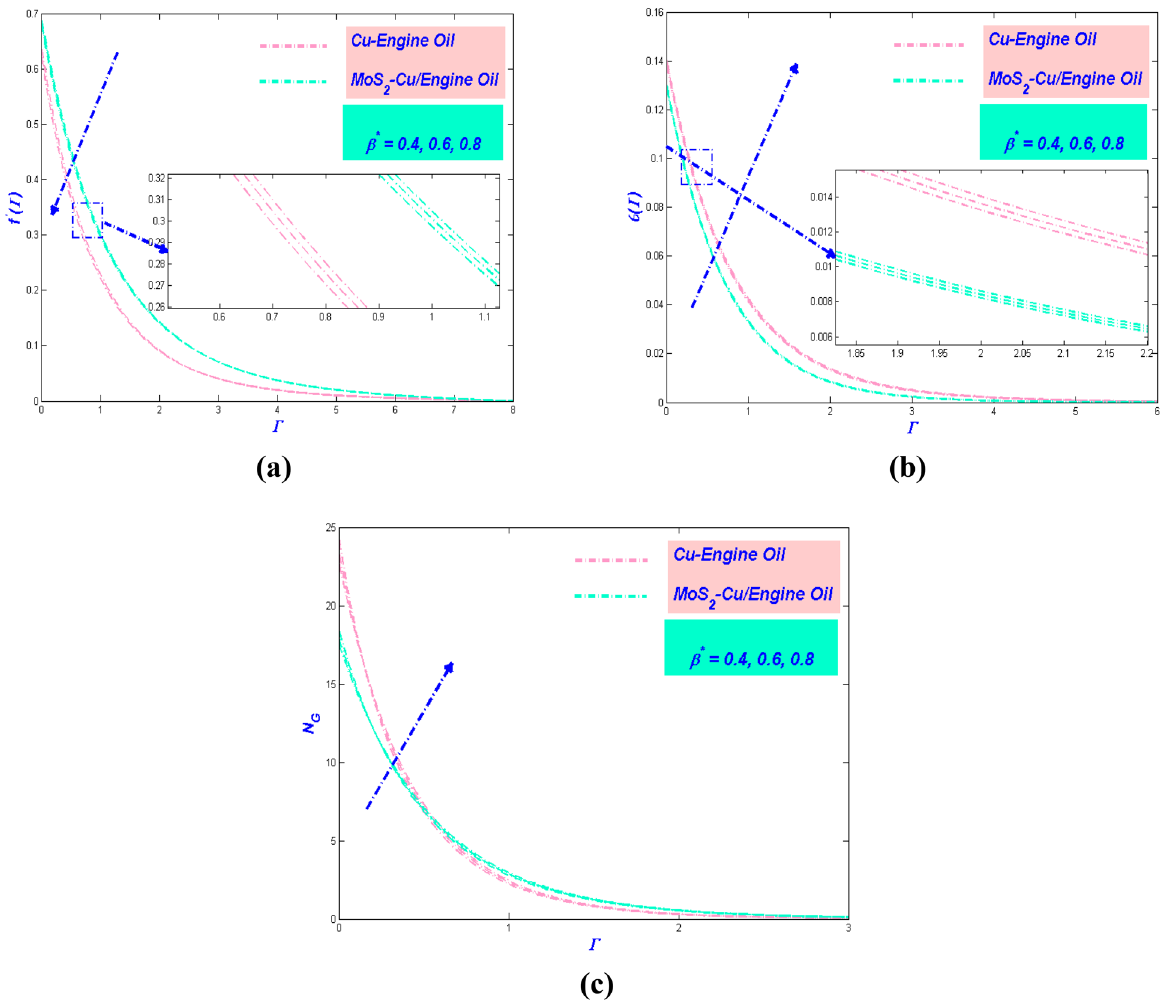
Figure 6. ( a ) Velocity, ( b ) temperature and ( c ) entropy variation versus β ∗